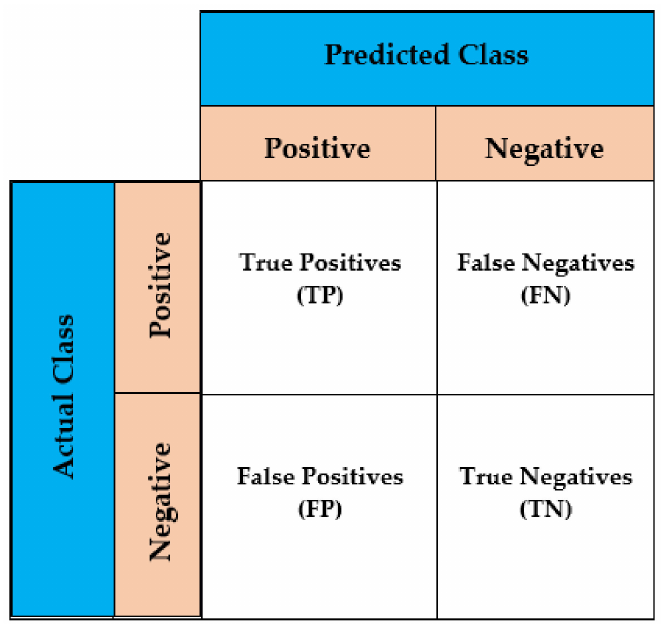
Figure 3. Confusion